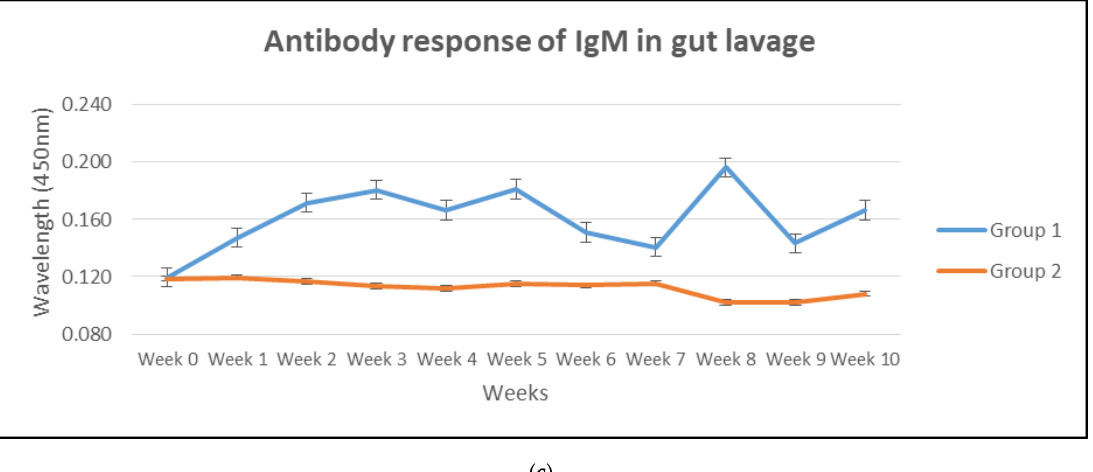
Figure 2. Specific ( a ) mucus, ( b ) serum, and ( c ) gut lavage IgM antibody titers were determined using ELISA assay in Group 1 and 2. First vaccination and booster were given on week 1 and 2, while the challenge was on week 4. Error bar indicates significant differences at p < 0.05.